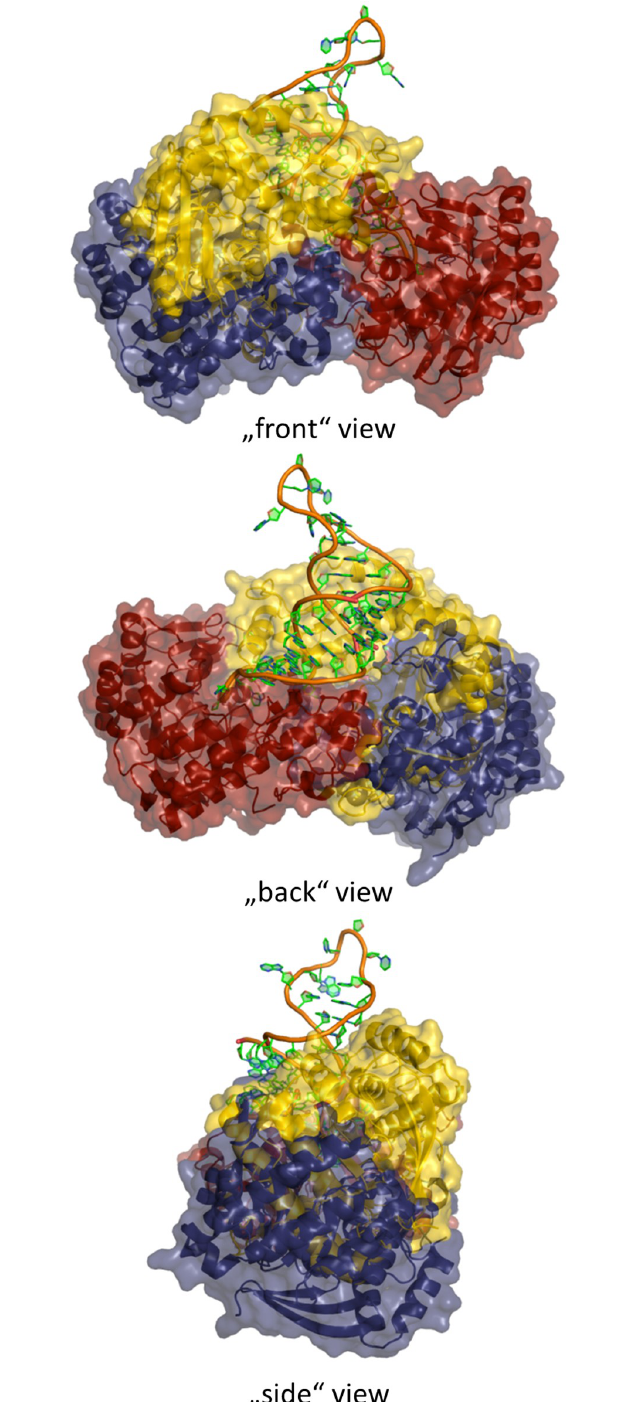
Fig 10. Alignment of TGT (cid:1) RNA (PDB entry: 1Q2R [14]) and twisted dimer found in TGT (cid:1) 9 co . The protein is represented as solvent accessible surface and cartoon with the followingcolor code: twisted dimer: Monomer1 red, Monomer2 yellow. TGT (cid:1) RNA: Monomer1 adopts a very similar orientationin space as in the twisted dimer (for the sake of clarity not shown in the figure). Monomer2 blue. RNA: backboneorangeand nucleosides green